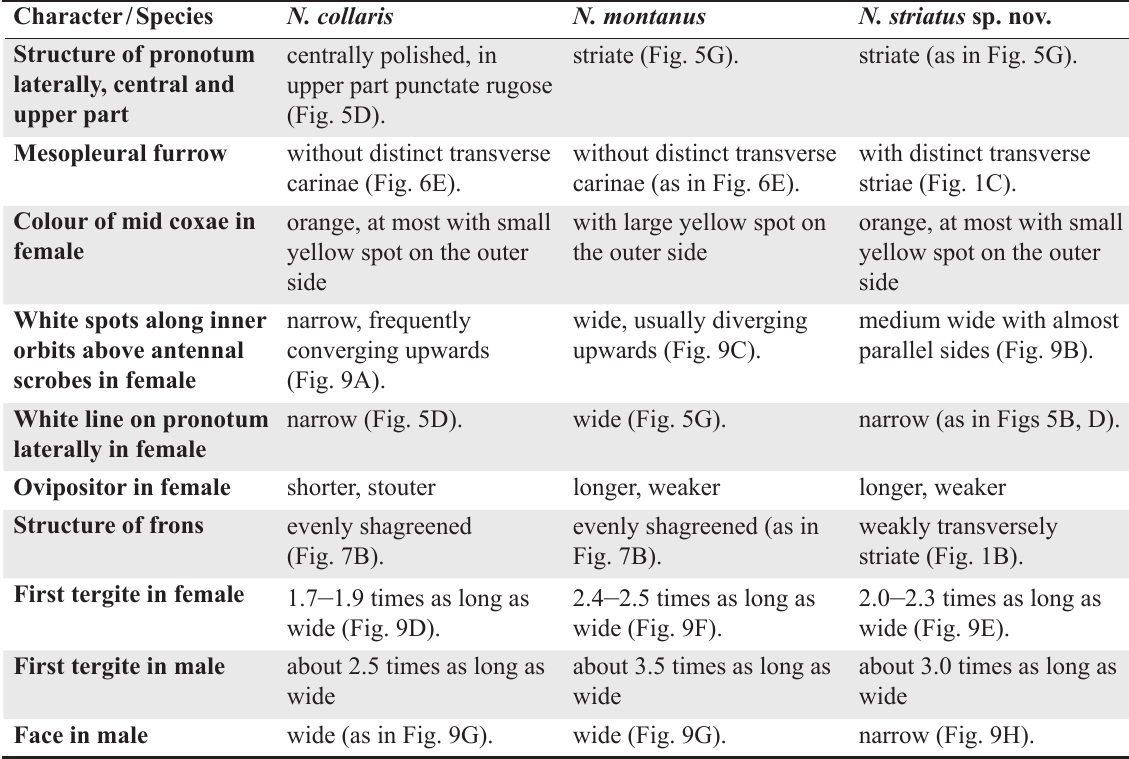
Table 2. Distinguishing characters for Neoxorides collaris (Gravenhorst, 1829), N. montanus (Oehlke, 1966) and N. striatus Johansson sp.